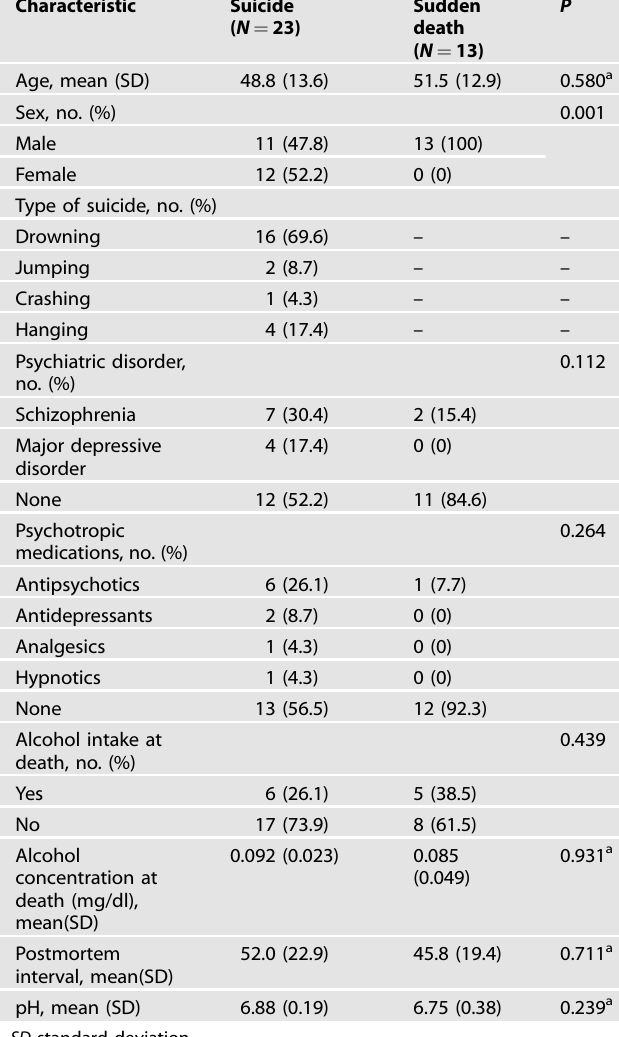
Table 1. Clinical characteristics of suicide completers and sudden death